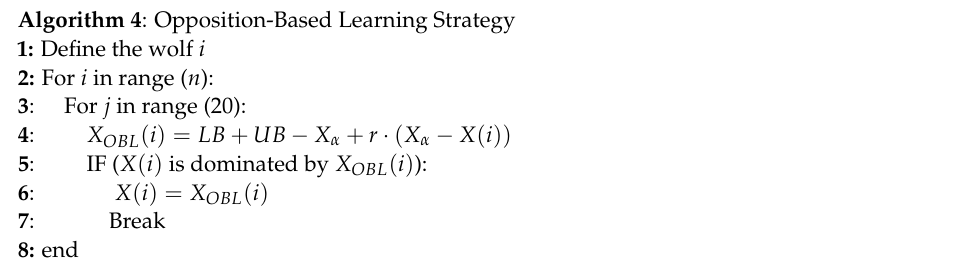
Algorithm 4 : Opposition-Based Learning